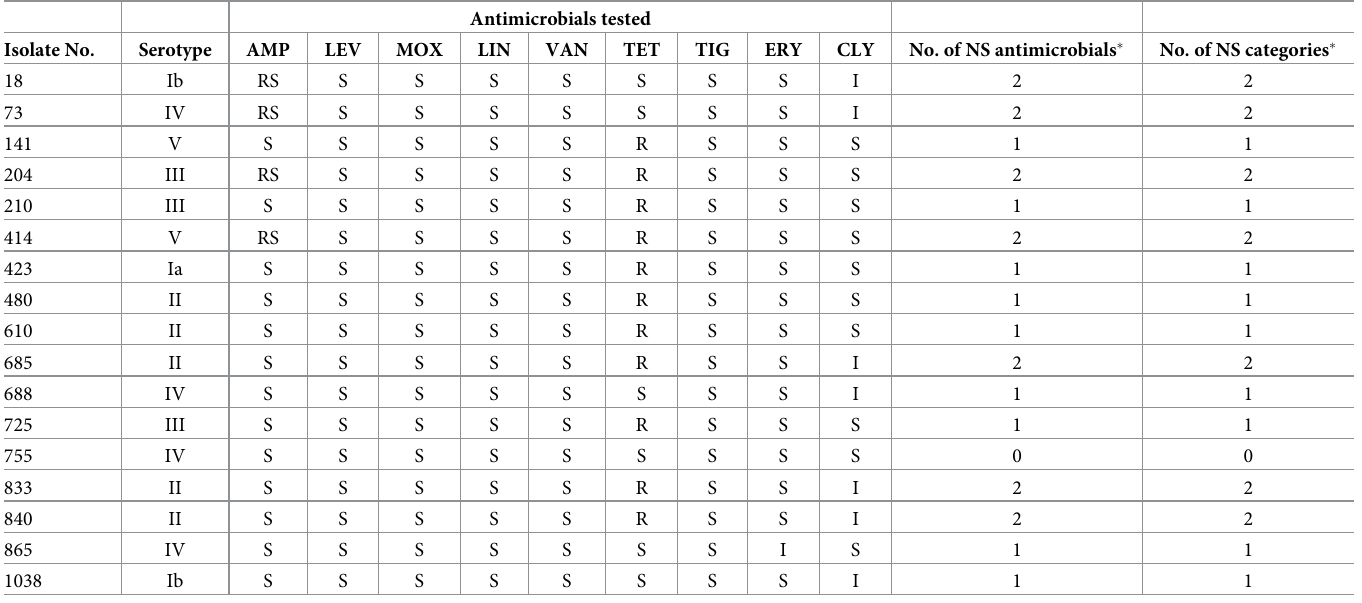
Table 4. Antimicrobial susceptibility and antimicrobial categories of 17 group B Streptococcus . Antimicrobials tested